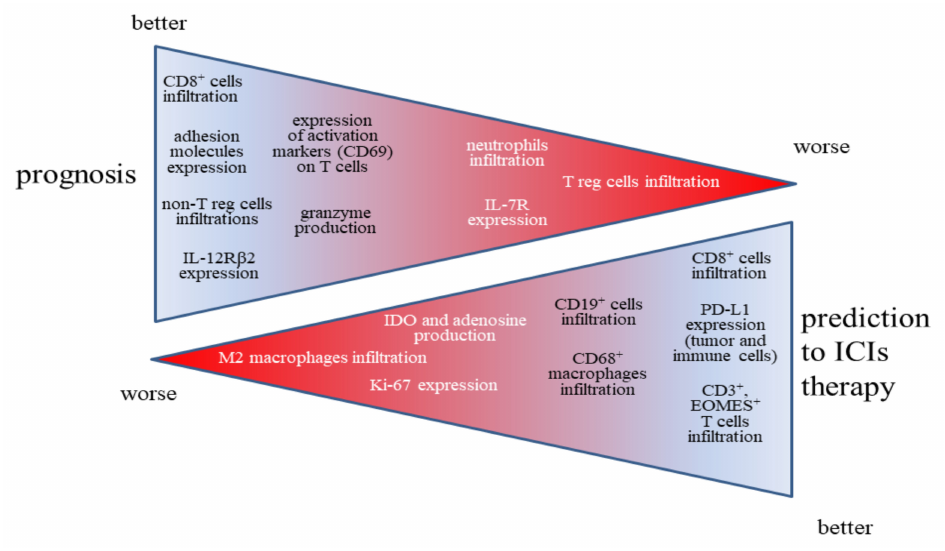
Figure 1. The summary of the immune markers associated with the prognosis and with the prediction of response to immunotherapy of lung cancer